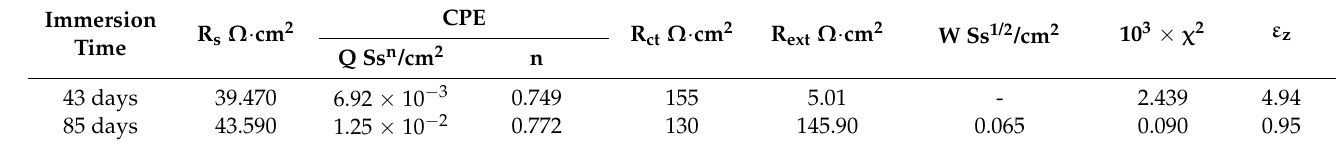
Table 4. Equivalent circuit element values for C45 immersed for various periods in